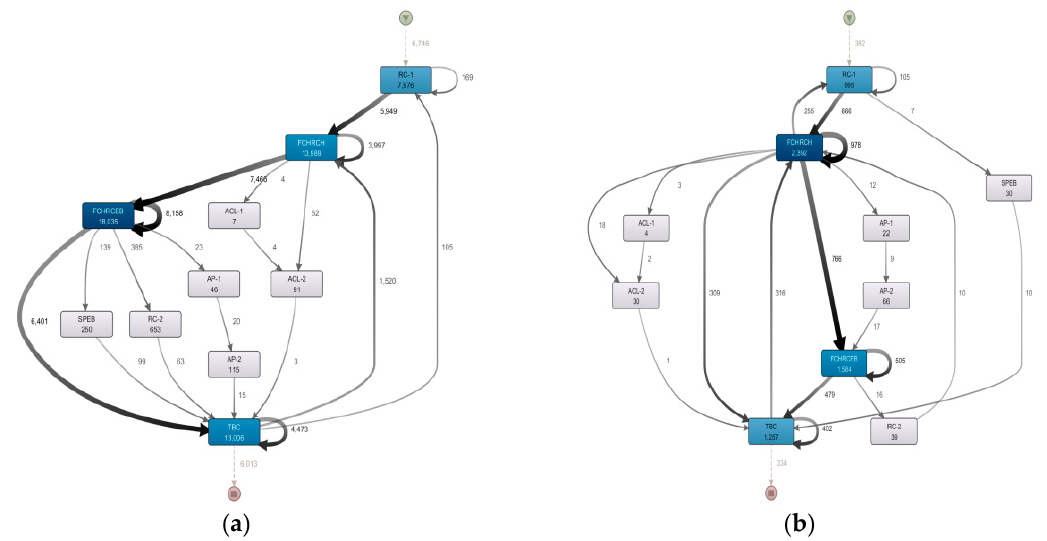
Figure 9. Process models of general ( a ) and major ( b ) complaint handling service (CHS) cases.